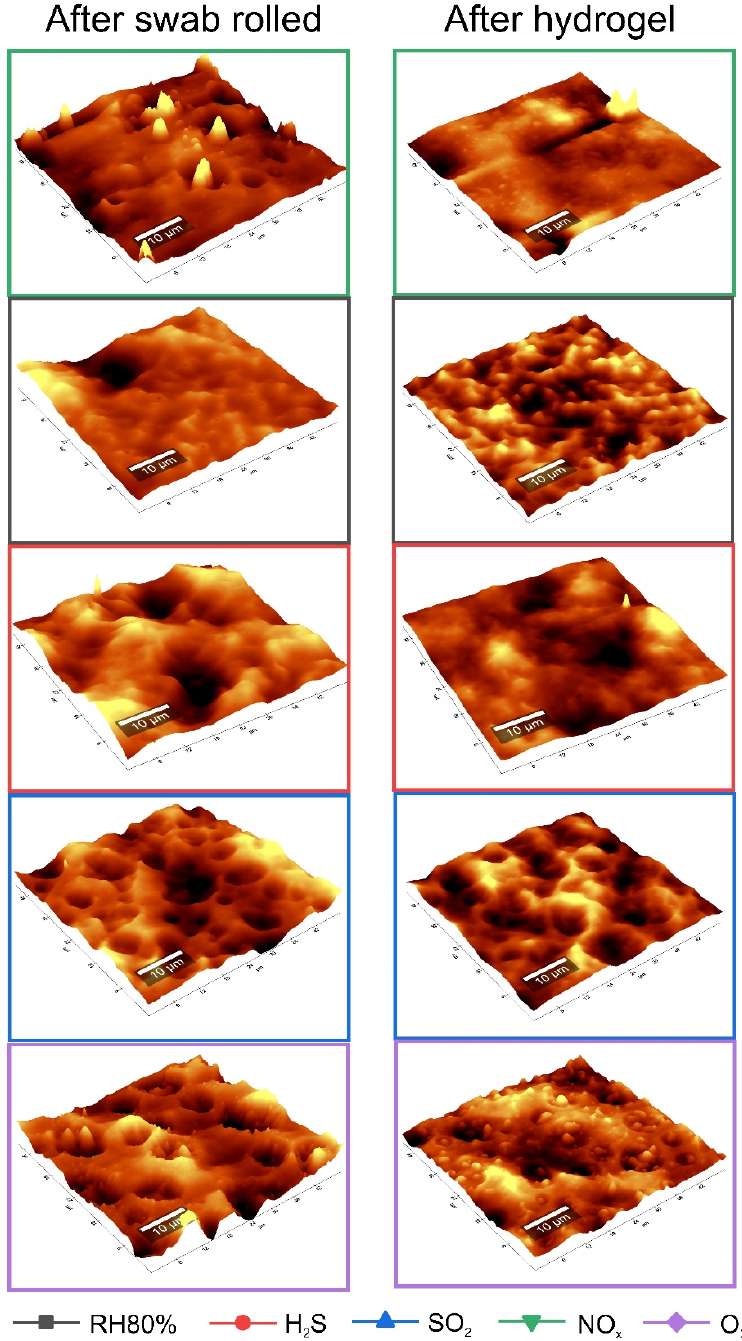
Figure 4. AFM topographies after gas aging and cleaning with swab rolled and hydrogel test.